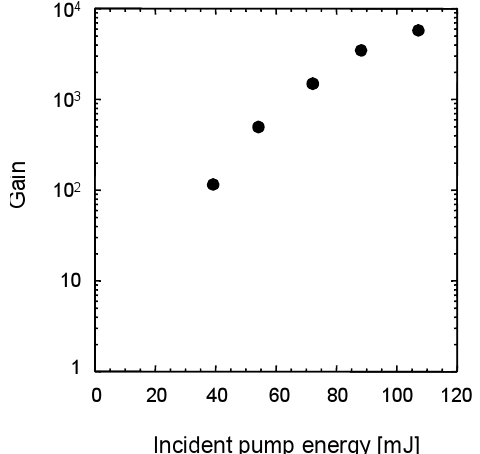
Figure 2. Gain from optical parametric chirped-pulse amplification (OPCPA) preamplifier stage versus pump